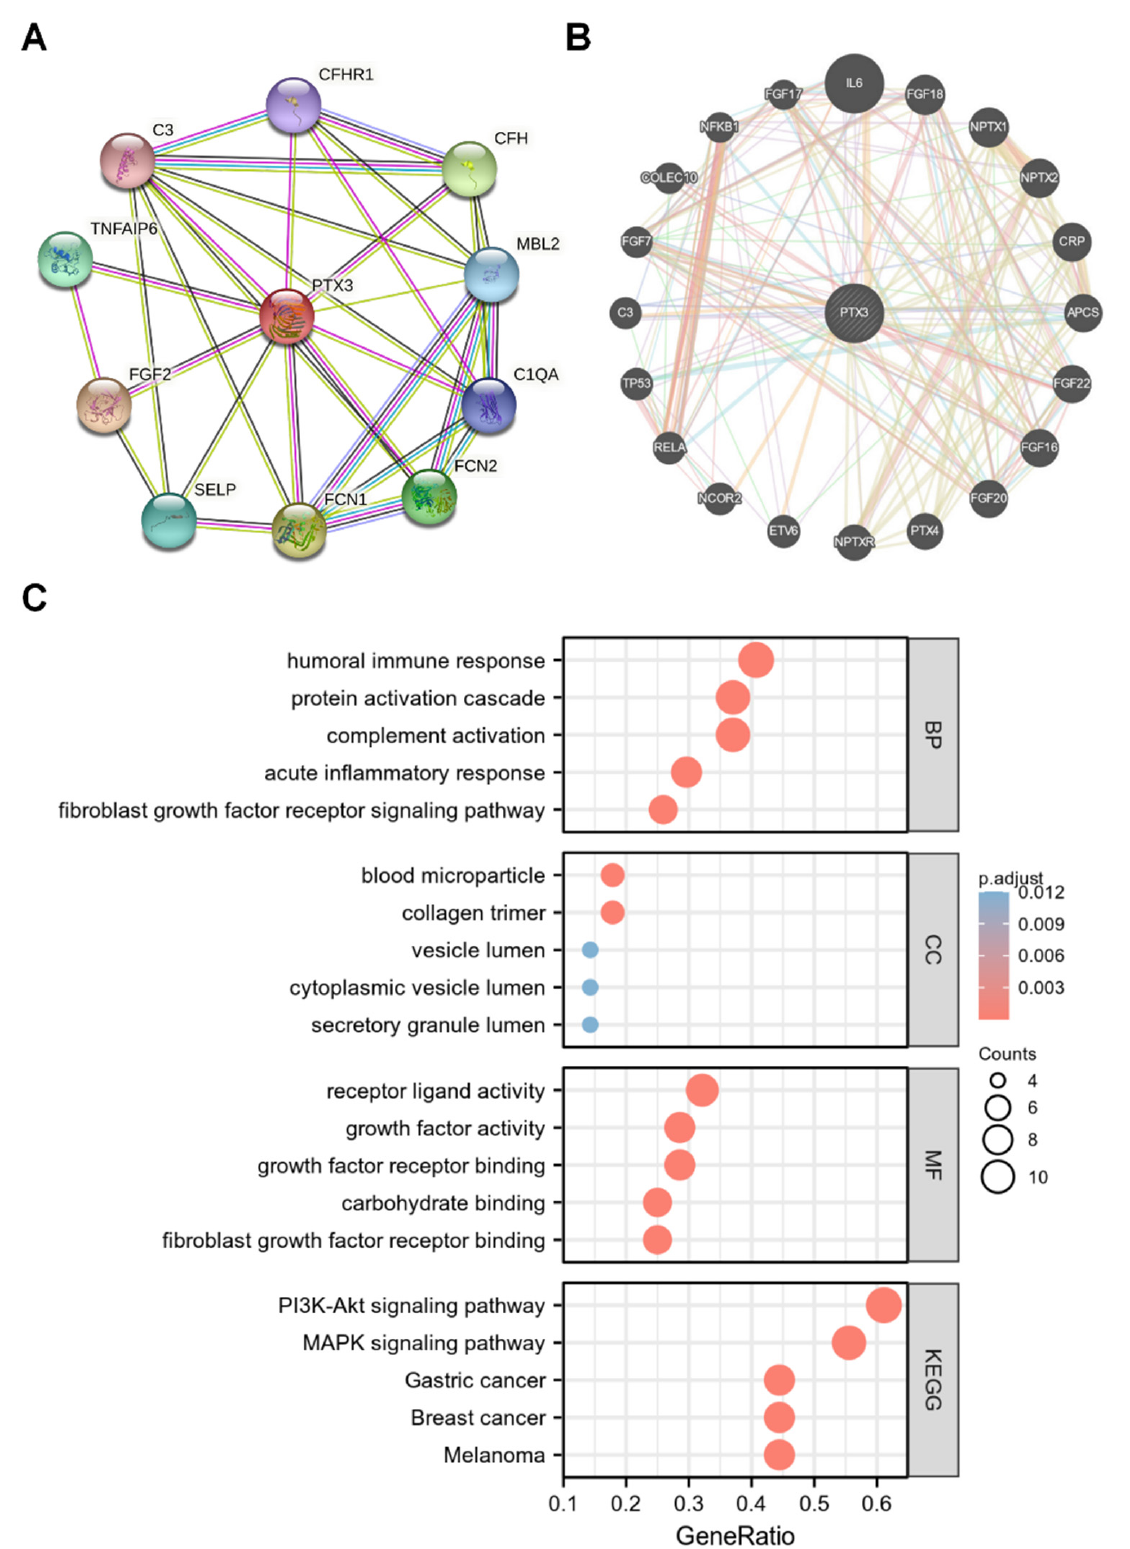
Figure 6. The interaction network of PTX3: ( A ) The interaction genes of PTX3 in STRING; ( B ) the PPI network of PTX3 in GeneMania; ( C ) KEGG and GO analyses of PTX3 based on the interacted genes obtained from STRING and GeneMania.